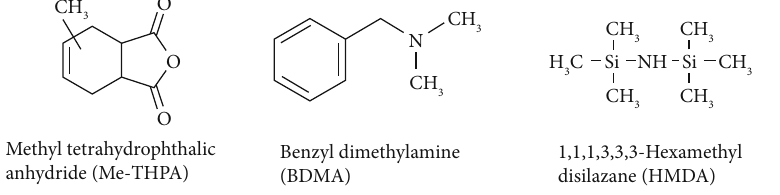
Figure 1: Chemical structure of